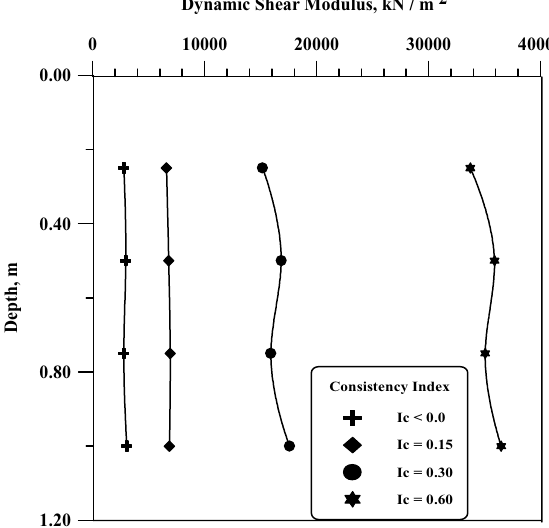
Fig. 4. Variation of dynamic shear modulus of clay with depth.